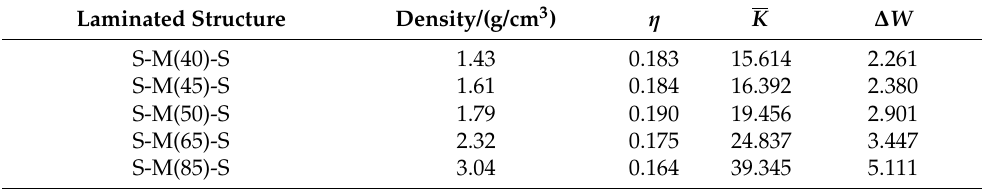
Figure 14. Hysteresis loops with different MR density. Table 7. Dynamic properties based on the density of the MR matrix.